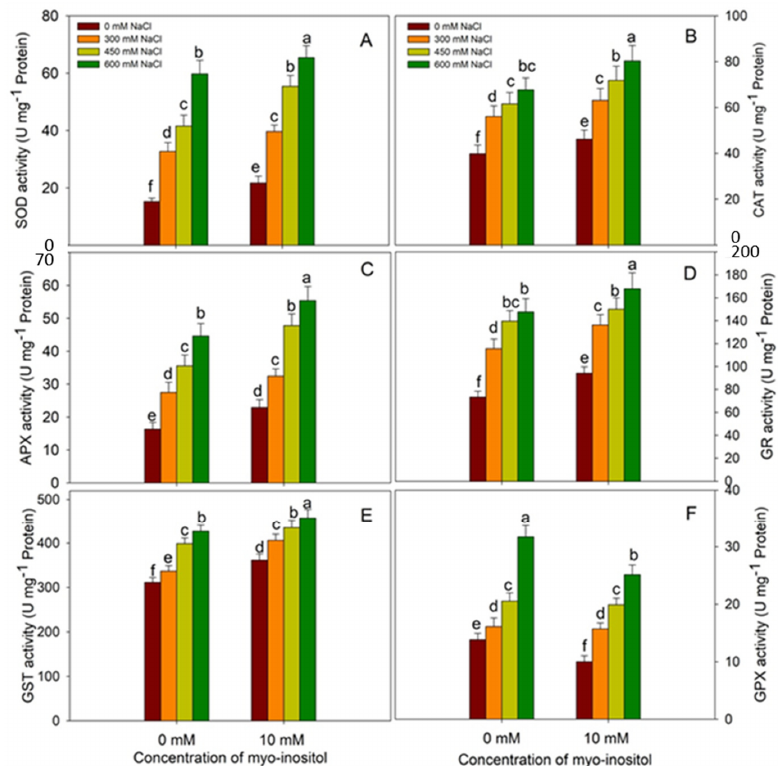
Figure 7. Effect of different salinity (300, 450, and 600 mM NaCl) concentrations with and without exogenous application of myo-inositol (10 mM) on changes in enzymatic antioxidant status